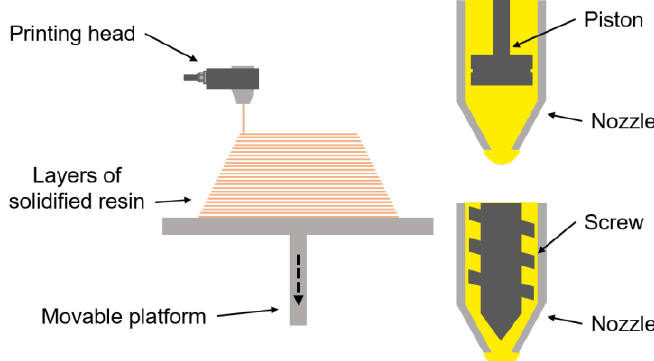
Figure 10. Schematic of a typical DIW printing method.